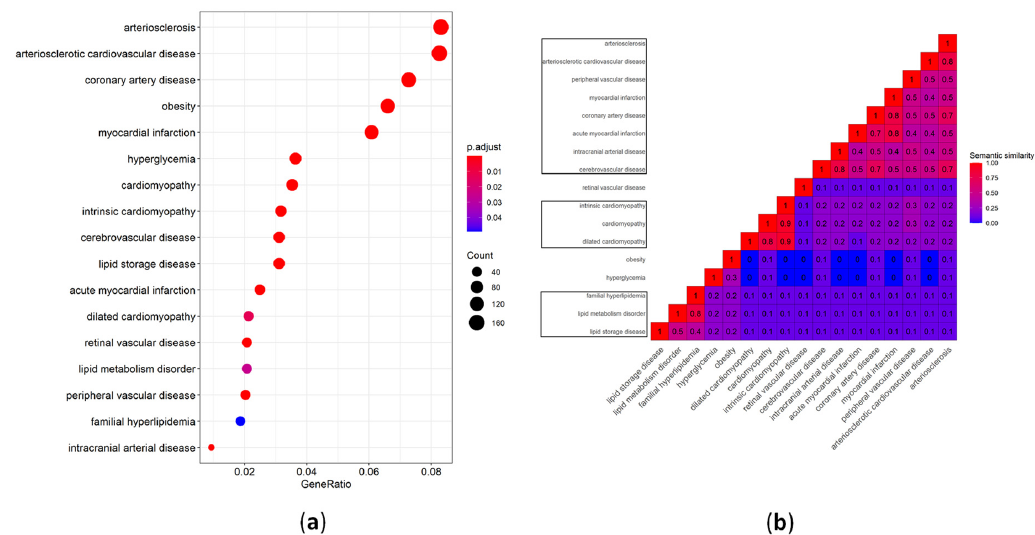
Figure 1. Selected CVD-associated DOSE terms that are enriched in the validated gene targets of CVD-associated miRNAs. ( a ) Dot plot of statistically significant, CVD-associated DOSE terms, displaying the gene ratio and statistical significance ( p -value < 0.05, following Bonferroni adjustment). ( b ) Heat map displaying the semantic similarity between the CVD-associated DOSE terms. The DOSE term similarity measurements were performed using the method of Wang et al. [57] and clusterProfiler [55,56]. The DOSE terms were clustered using hierarchical clustering. Clusters with two or more terms are specified with black-colored borders. The heat map was created using ComplexHeatmap [58].